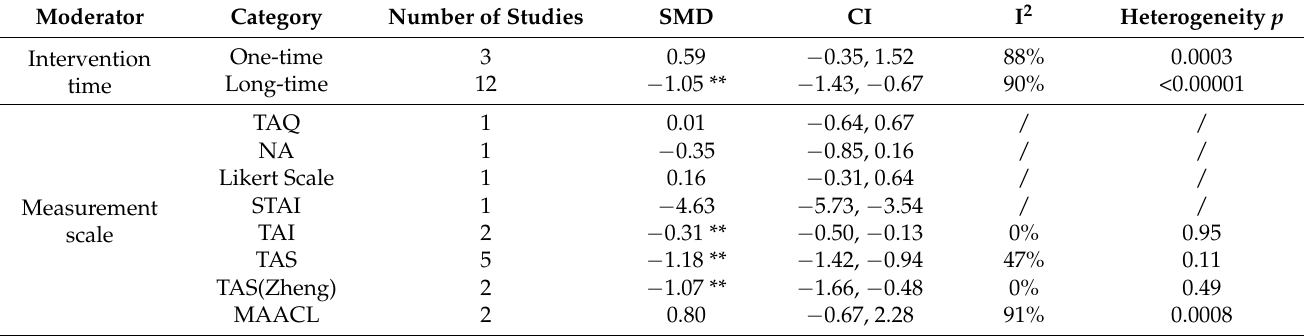
Table 4. Results of subgroup analysis on the effect of exercise intervention on students’ test anxi- ety.